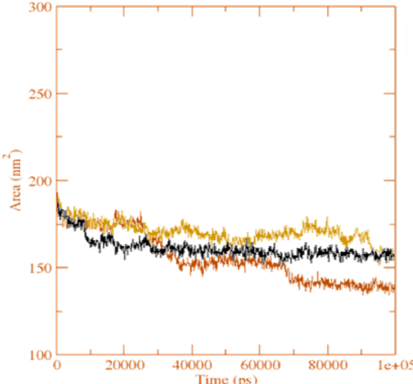
Figure 15. The solvent accessible surface area analysis for the unbound serotonin receptor (yellow), GpnS complex (black), and CuGS complex (brown) during the 100 ns simulation time.